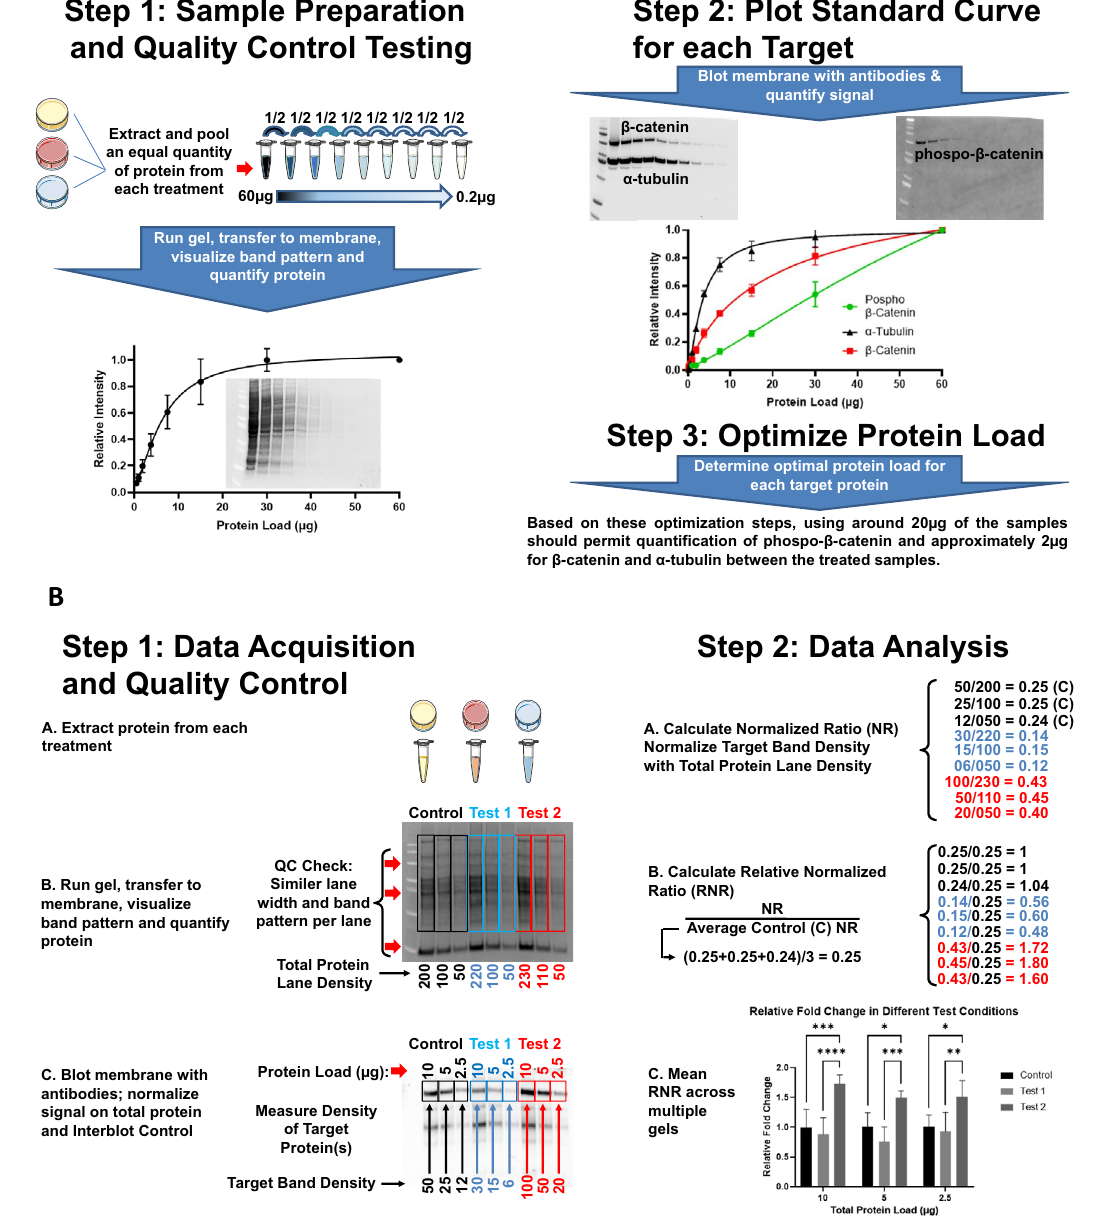
Figure 3. Quantitative western blot workflow summary. ( A ) Optimization of the assay for the specific set of samples using a specific target. Step 1: Sample Preparation and Quality Control Testing. Produce a pooled lysate from all treatments to a maximum initial concentration of 4 µg/µl and produce a standard curve by diluting serially by a factor of 1:2 for seven dilutions loading 20 µl per well on an SDS-PAGE gel. After gel-based separation, transfer to membrane using a consistent transfer apparatus and assess the total protein transferred (see "Methods"). Step 2: Plot Standard Curve for each Target. Probe the membrane with each antibody. Plot the relative density of each protein versus protein load to generate a standard curve. Step 3: Optimize Protein Load. Determine the optimal total protein load by choosing the protein load corresponding to the middle of the standard curve linear range for each target. This offers the best chance of achieving target-specific quantitative data from the individual samples. ( B ) Quantification of Target Expression. Step 1: Data Acquisition and Quality Control. Assure that the total protein loaded per lane is within the linear dynamic range of the target protein for accurate normalization and sample quality verification. Step 2: Data Analysis. Use a similar methodology as qPCR 40 to work up the data from western blotting to assure the results reflect the tested experimental conditions. The blot images from this figure are strictly to depict the western blot workflow, associated quality controls and data analysis steps with contrived data to clarify the data analysis